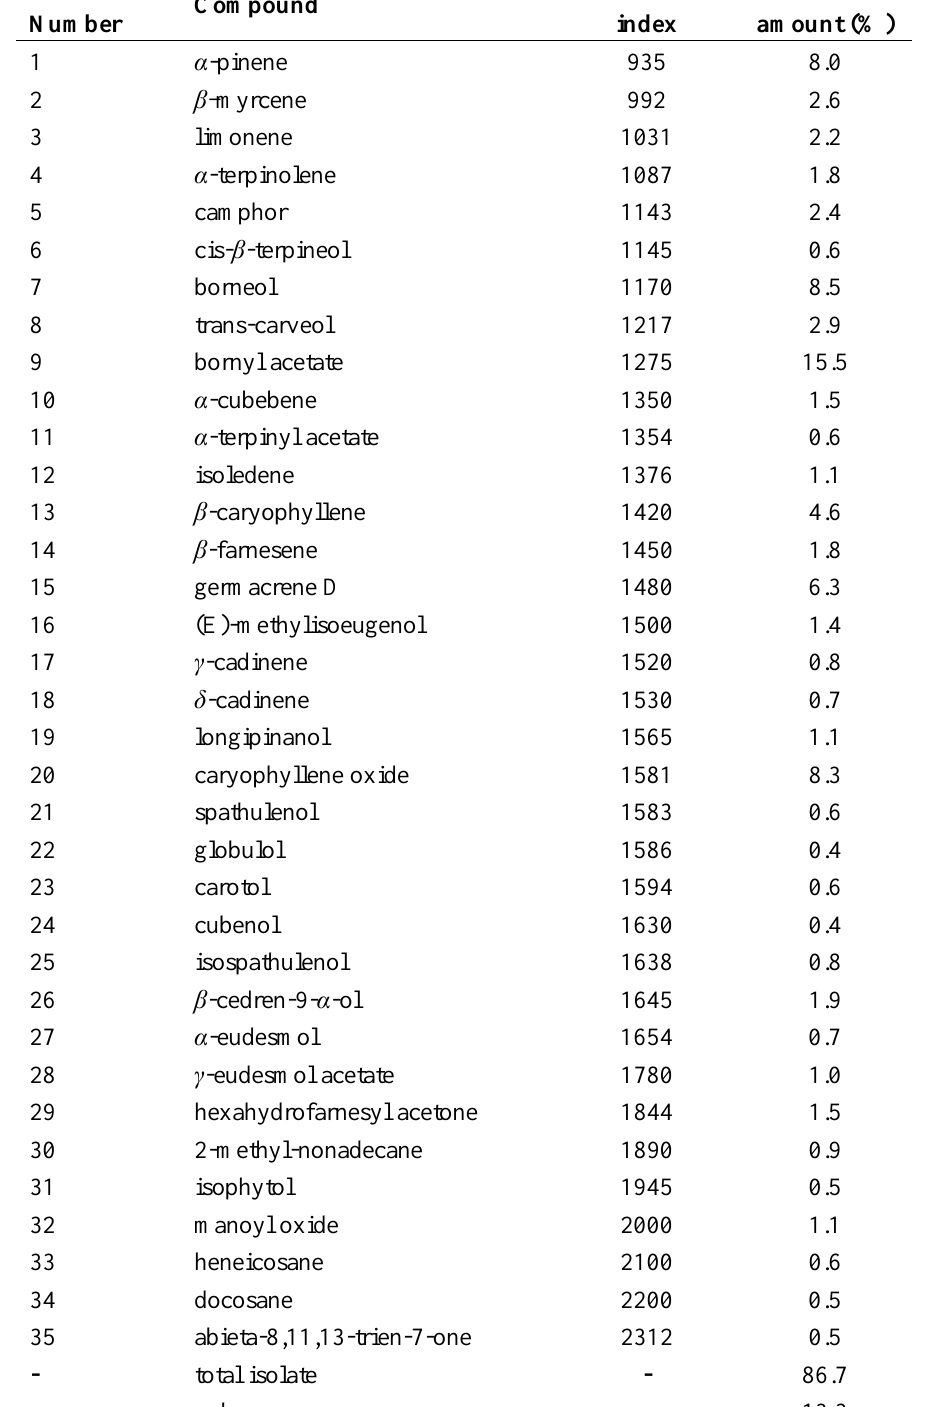
Table 1. Chemical composition of the essential oil from A. trifida from Northeast China